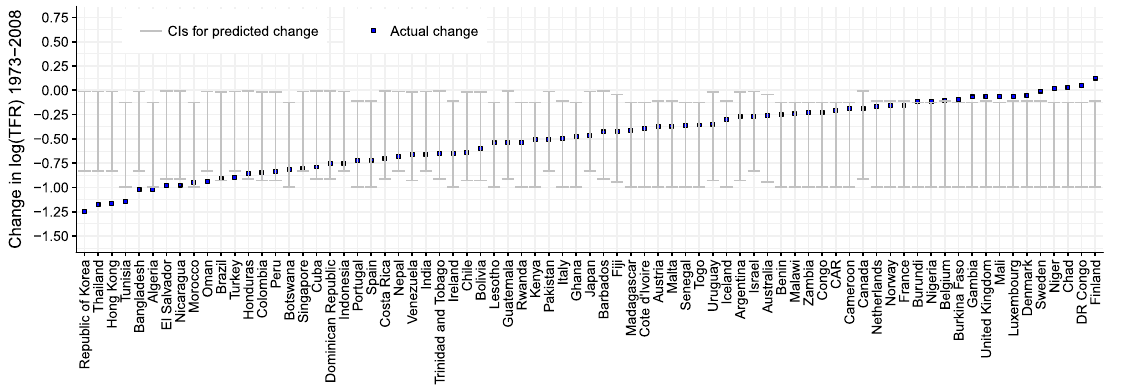
Figure 5: The confidence intervals show the predicted change in log ( TFR ) from 1973–2008 for all countries when not using the data of the country’s continent in the estimation (with implied coverage guarantee 80%). Only those countries are displayed for which log ( TFR ) in 1973 and 2008 were not missing in the data. For nonlinear ICP the shown intervals are the union over the accepted models’